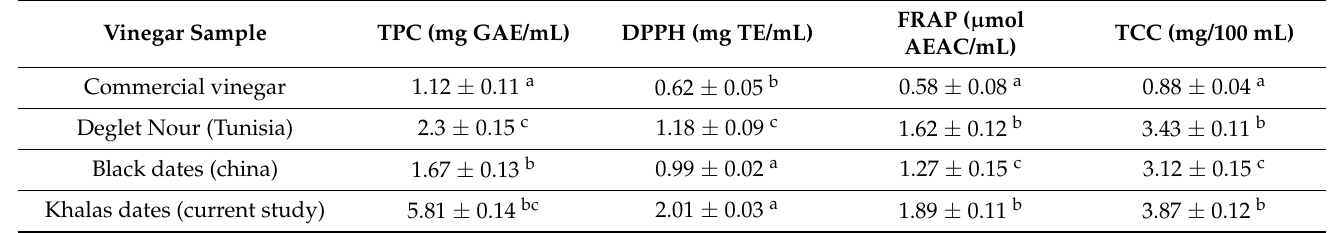
Table 6. The total phenolic contents, antioxidants, and total carotenoid content of produced date vinegar and comparison with commercial vinegar and other tested date